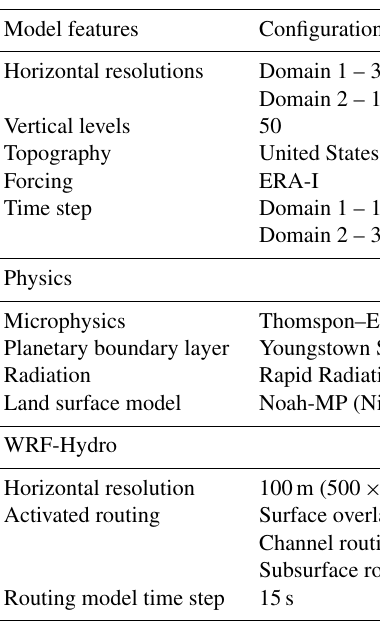
Table 1. WRF and WRF/Hydro model